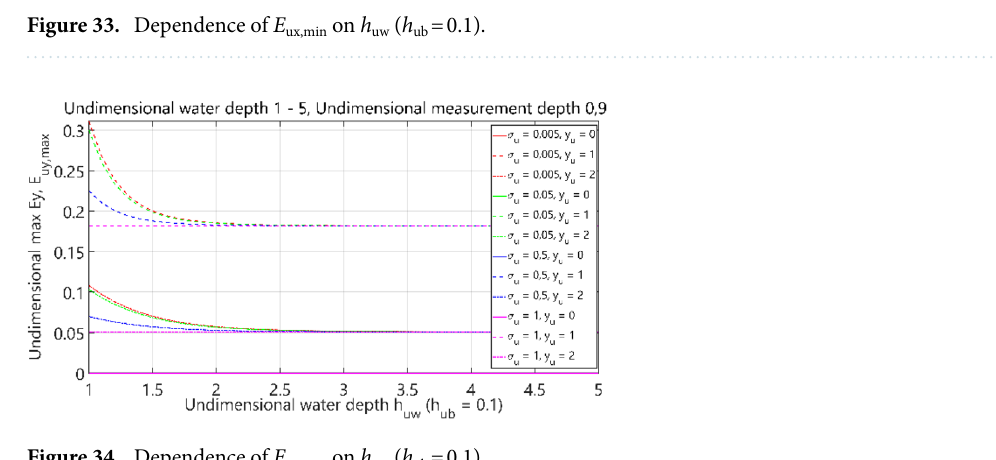
Figure 34. Dependence of E uy,max on h uw ( h ub =